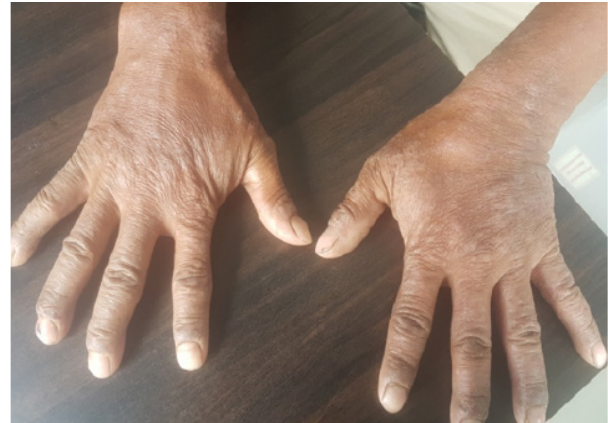
Figure 2: irritant contact dermatitis in industrial worker. (Permis- sion was obtained from patient to display photo image)